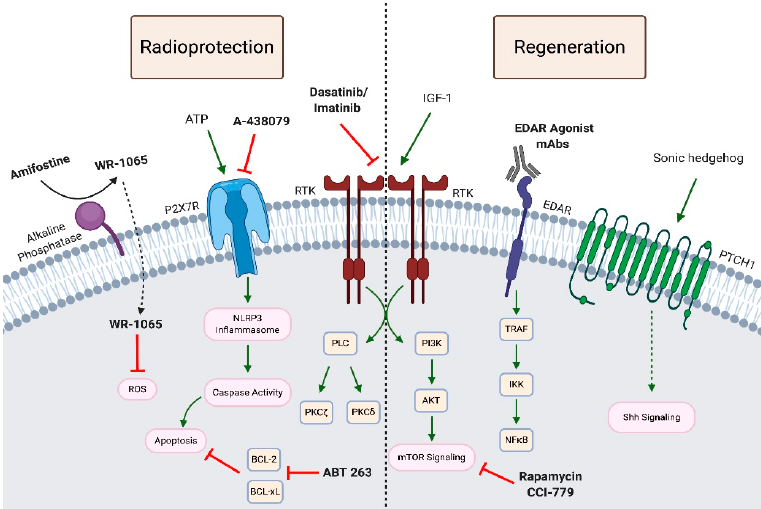
Figure 4. Pharmacological Approaches to Salivary Gland Radioprotection and Regeneration.